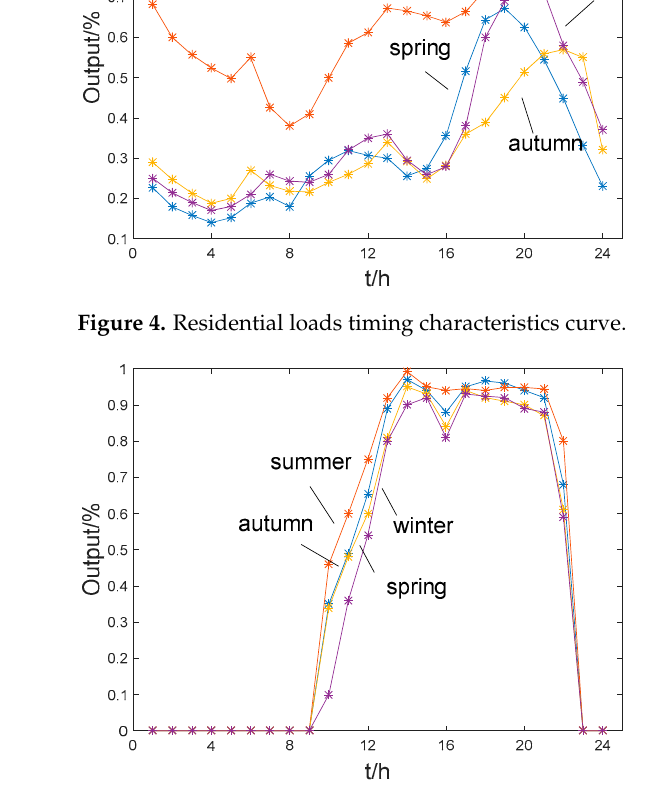
Figure 5. Commercial loads timing characteristics curve.